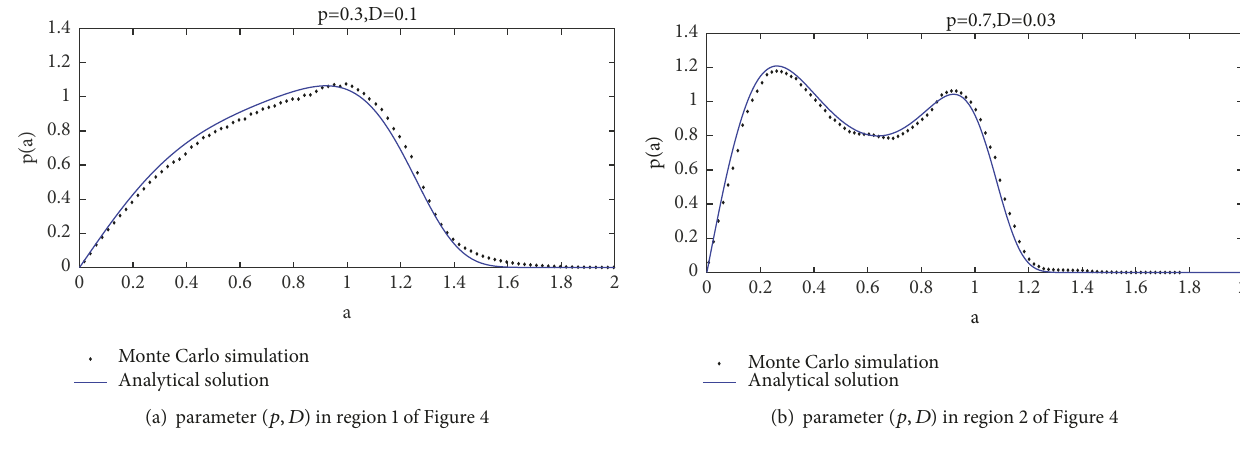
(b) parameter ( 𝑝,𝐷 ) in region 2 of Figure 4 Figure 5: The stationary PDF curves for the amplitude of system